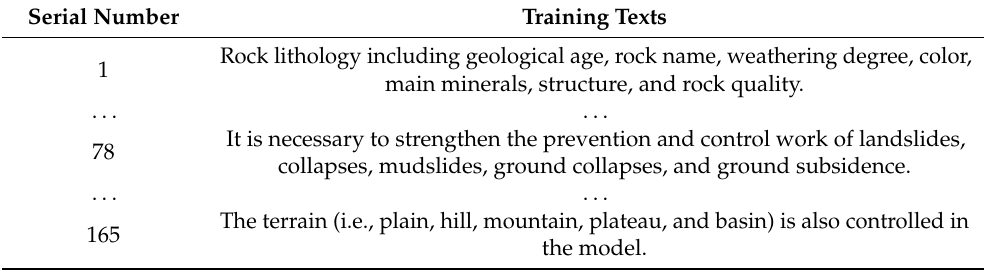
Table 1. Training texts with hierarchical